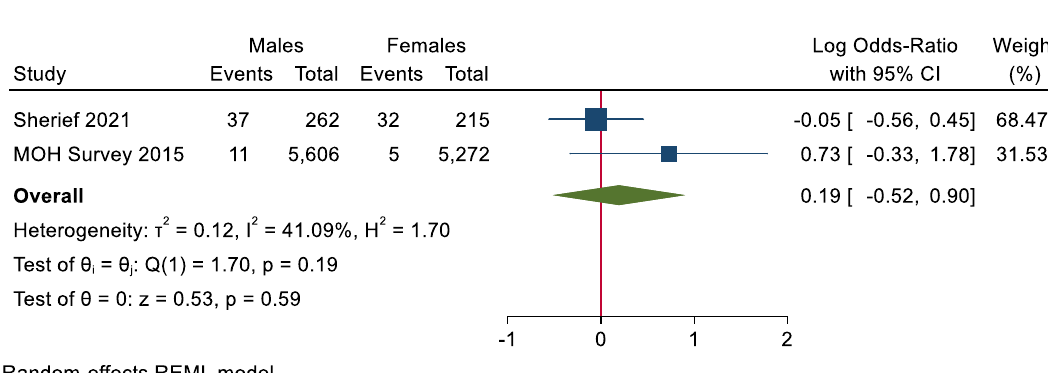
Figure 4. Forest plot of seroprevalence of HCV antibodies in males and females in children. There is no significant difference between males and females in HCV antibodies prevalence.